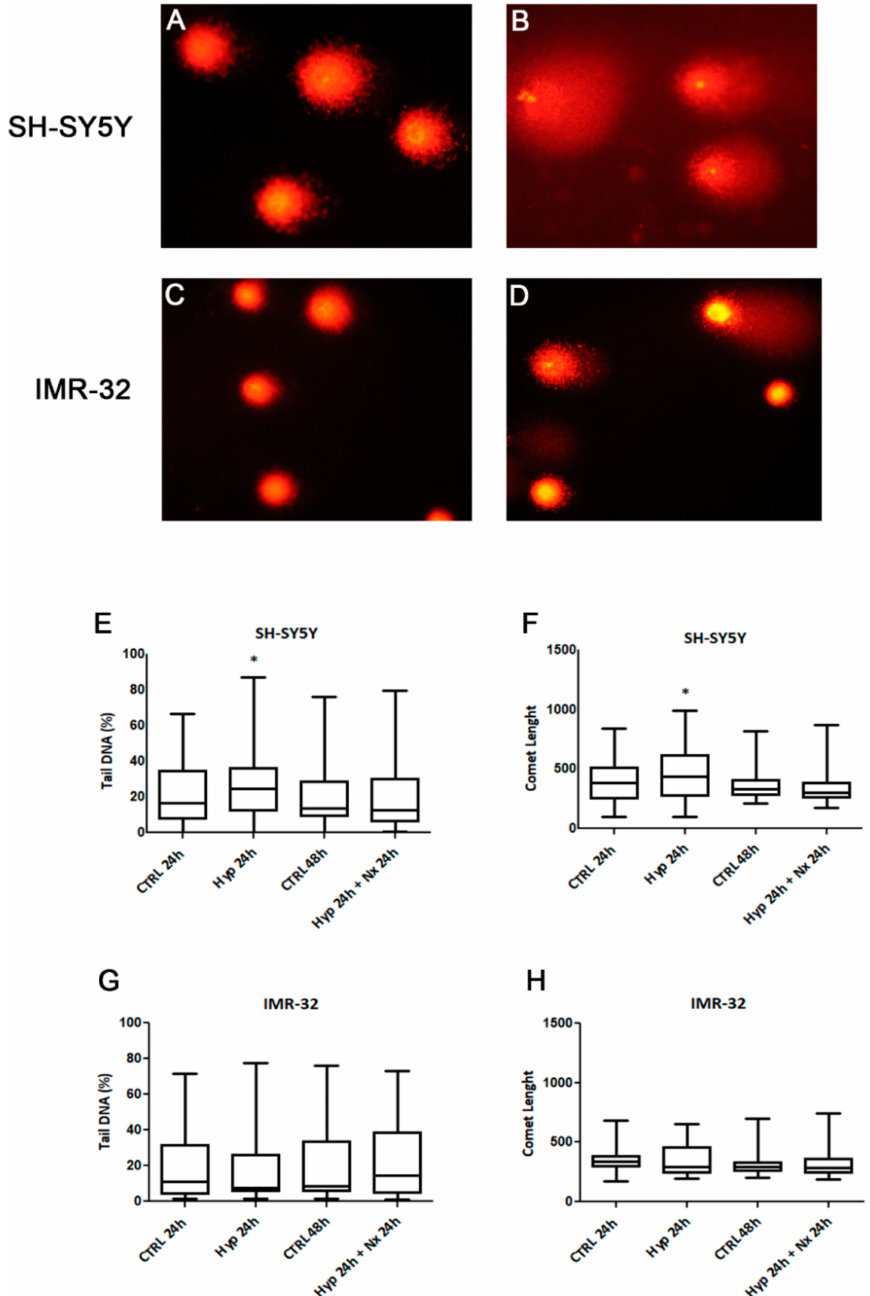
Figure 5. Comet assay pictures of DNA fragmentation in SH-SY5Y ( A , B ) and IMR-32 ( C , D ) NB cells exposed to normal O 2 ( A , C ) and hypoxic ( B , D ) conditions for 24 h., and graphs of Comet parameters calculated in cell cultures exposed or not to hypoxia for 24 h followed by reoxygenation for further 24 h ( E – H ). Values are expressed as median, 25th and 75th percentiles and minimum and maximum. * p < 0.05 significant di ff erence in comparison to control